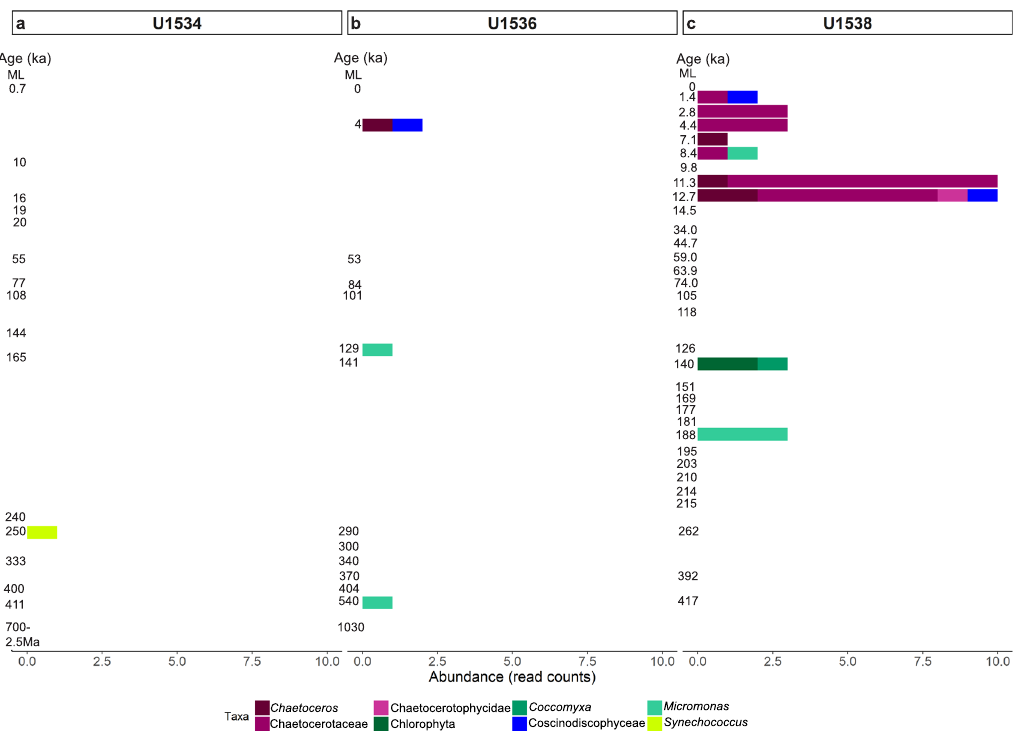
Fig. 4 | Abundance of photosynthetic organisms at IODP Exp. 382 Sites U1534, U1536, U1538. Abundance of the psbO gene (read counts) determined at Exp. 382 SitesU1534(Hole C)( a ),U1536(HoleB)( b )and U1538(HolesCand D)( c ).Left axis shows the age estimate (where an age but no bar is shown, no psbO reads were